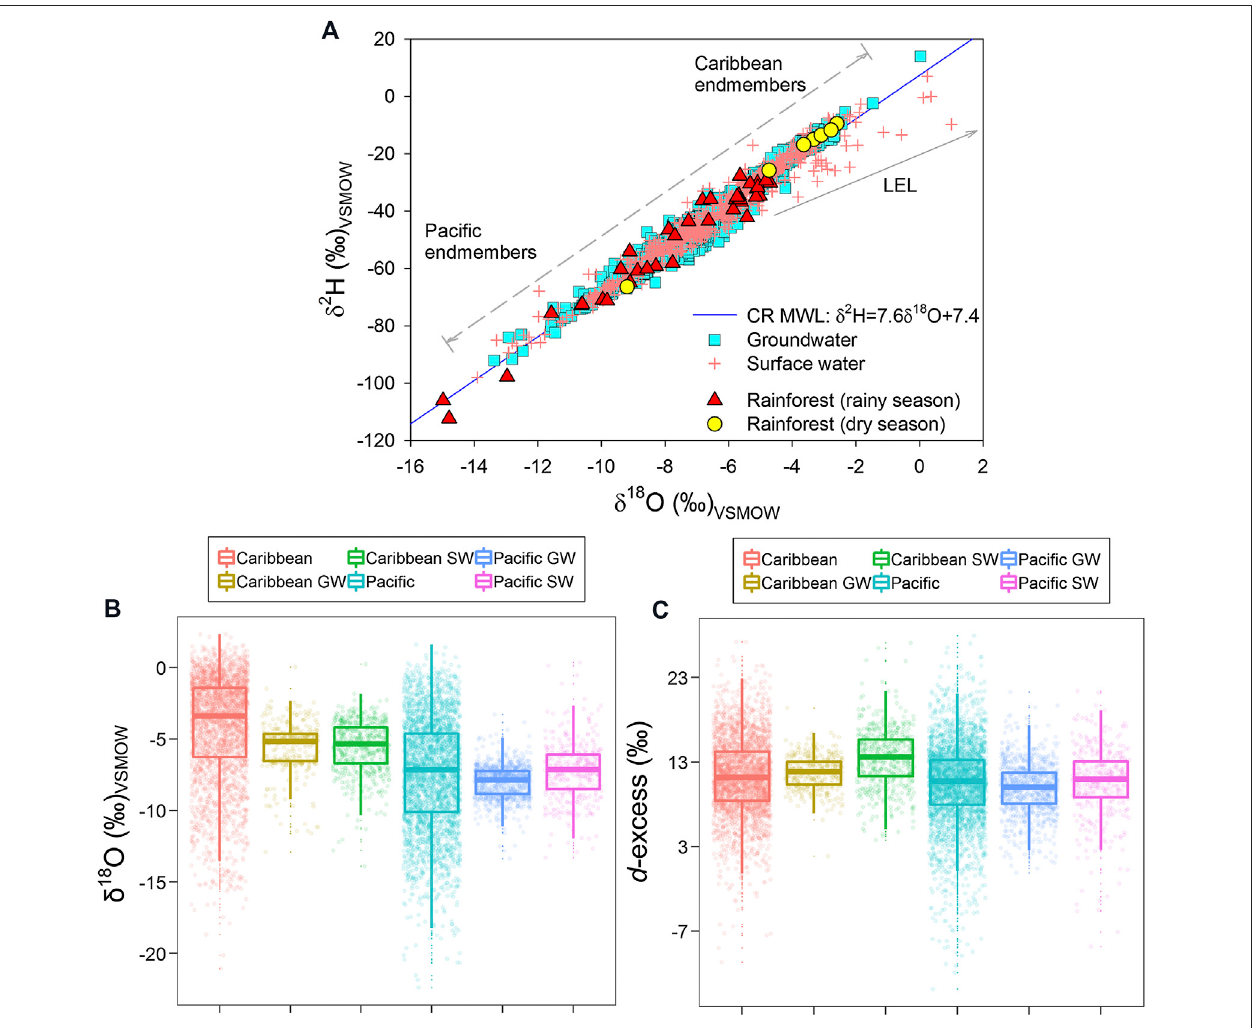
FIGURE 10 | Dual isotope diagram and scattered box plots of rainfall, groundwater, and surface waters across the Caribbean and Paci fi c domains. (A) δ 18O and δ 2H relationship between groundwater (cyan squares), surface water (pink crosses) and soil water (yellow dots and red trinagles) compared to the Costa Rica meteoric water line (Sánchez-Murillo et al., 2013). LEL stands for local evaporation line. B) δ 18 O ( ‰ ) and C) d -excess ( ‰ ) box plots include 25th, 75th, median, and outliers for each group. Figure adapted using data from Sánchez-Murillo et al. (2020).